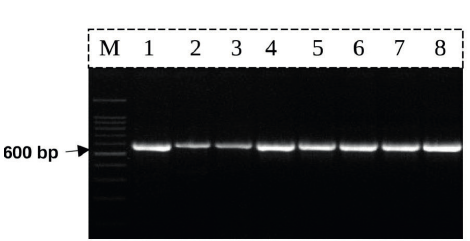
Fig. 1 . The gel electrophoresis result for the PCR product of rbcL primers.